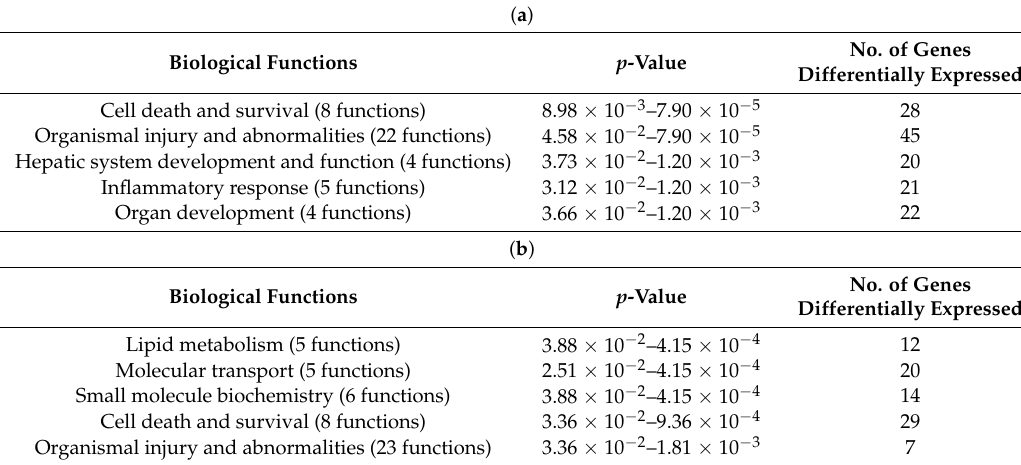
Table 1. The top five biological functions of hepatic genes that were significantly altered ( a ) by astaxanthin and ( b ) by vitamin E in mice with high-cholesterol, high-cholate, and high-fat (CL) diet-induced nonalcoholic steatohepatitis 1